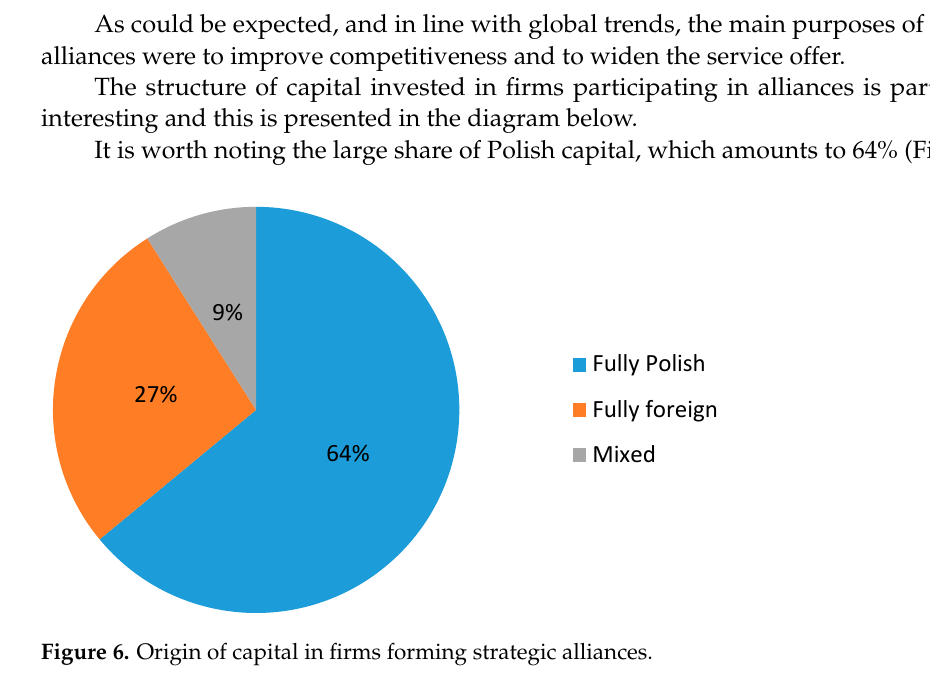
Figure 6. Origin of capital in firms forming strategic alliances.